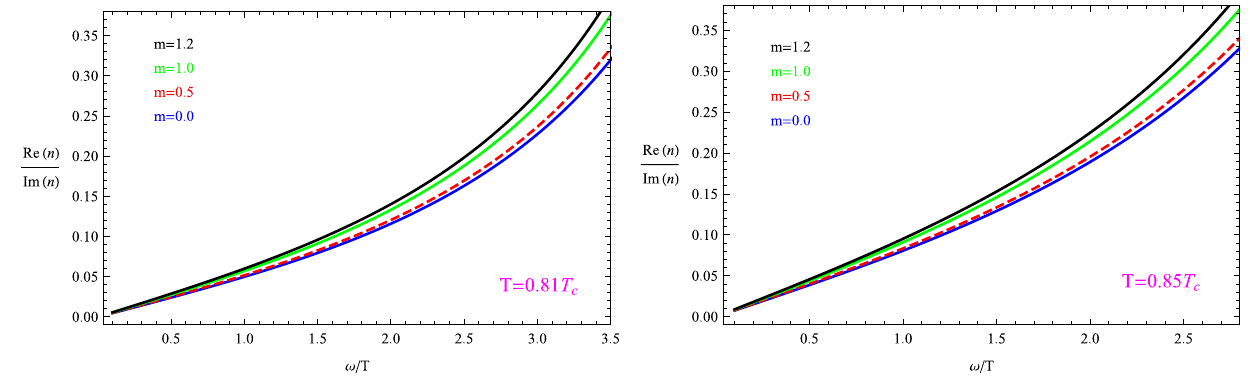
Fig. 7 Ratio Re( n )/Im( n ) as a function of ω/ T with the fixed temper- atures T = 0 . 81 T c (left) and T = 0 . 85 T c (right) for different values of the graviton mass parameter, i.e., m = 0 . 0 (blue), 0 . 5 (red dotted), 1 . 0